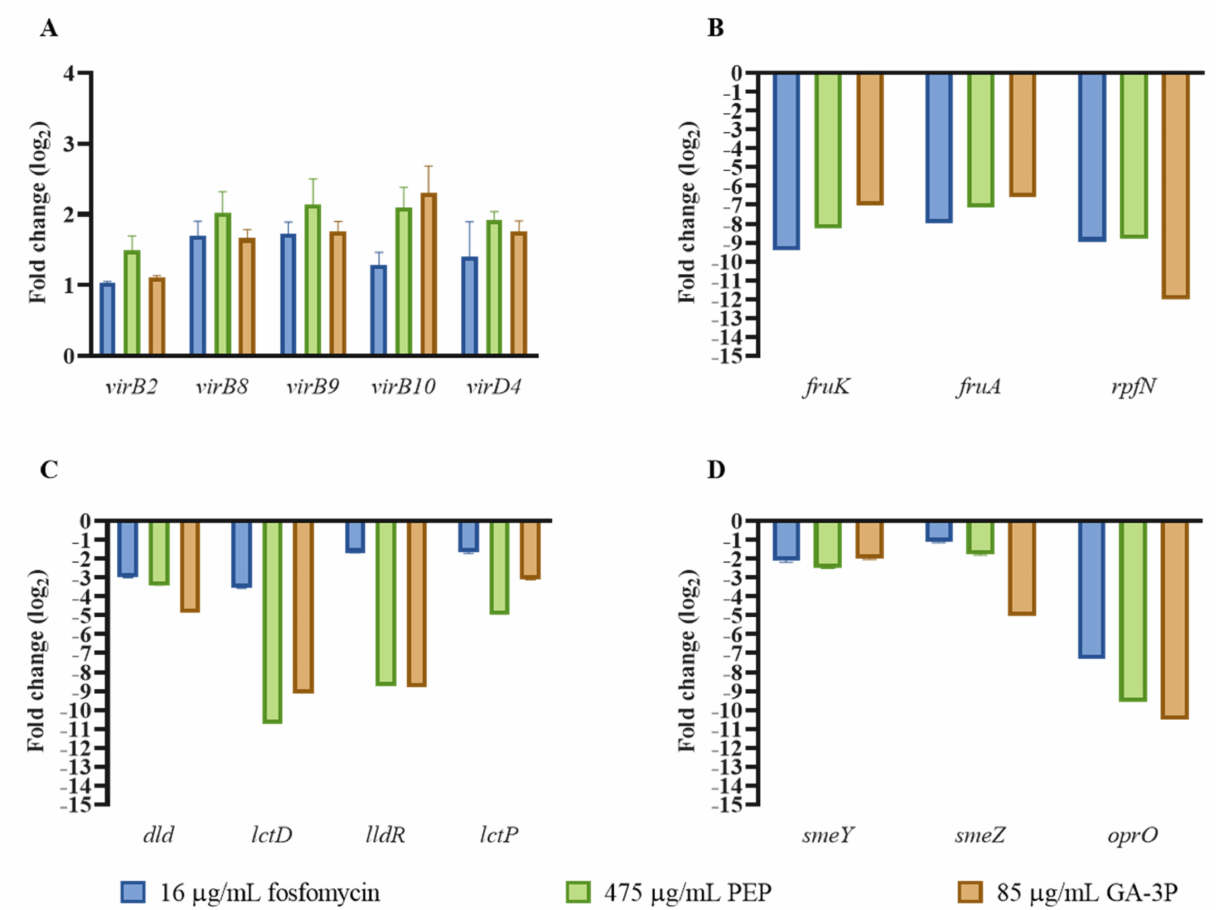
Figure 4. Analysis of expression by real-time PCR in the presence of fosfomycin, PEP, or GA-3P: ( A ) T4SS expression, ( B ) fructose PTS expression, ( C ) lactate operon expression and ( D ) expression of transporters after 1 h of incubation with 16 µ g/mL fosfomycin, 475 µ g/mL PEP, or 85 µ g/mL GA-3P. As shown, the expression of T4SS was induced by the three tested compounds ( A ). After the three treatments, the expression level of fructose and lactate operons, as well as important transporters ( B – D ), was reduced by 10-fold as compared with the untreated bacteria. Each represented value is the average of three biological replicates. Statistically significant differences compared to untreated D457 were calculated with a t -test for paired samples assuming equal variances with all of